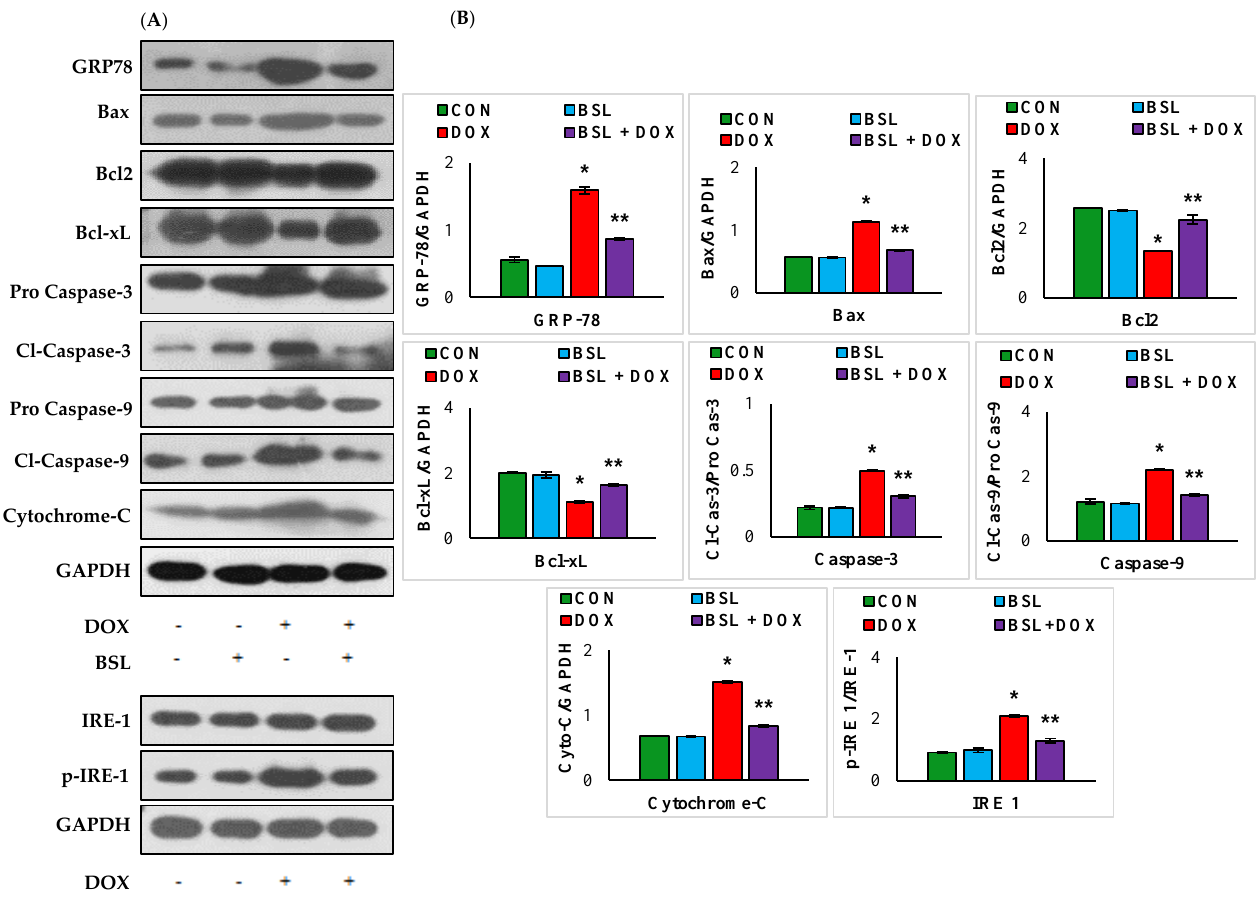
Figure 6. Effect of α -bisabolol on ER-stress-mediated intrinsic pathway of apoptosis in the testis. ( A ) Representative images of Western immunoblot analysis for Bax, Bcl2, Bcl-xL, procaspase-3, active caspase-3, procaspase-9, active caspase-9, cytochrome-C, IRE-1, and p-IRE-1 ( B ). Densitometric analysis of testicular protein expression levels of GRP-78, Bax, Bcl2, Bcl-xL, active caspase-3, active caspase-9, cytochrome-C, IRE-1, and p-IRE-1. Columns not sharing a common symbol (*,**) differ significantly from each other (* p < 0.05 vs. normal control, ** p < 0.05 vs. DOX control), CON-Control, BSL- α -Bisabolol, DOX-Doxorubicin, BSL + DOX- α -Bisabolol + Doxorubicin.